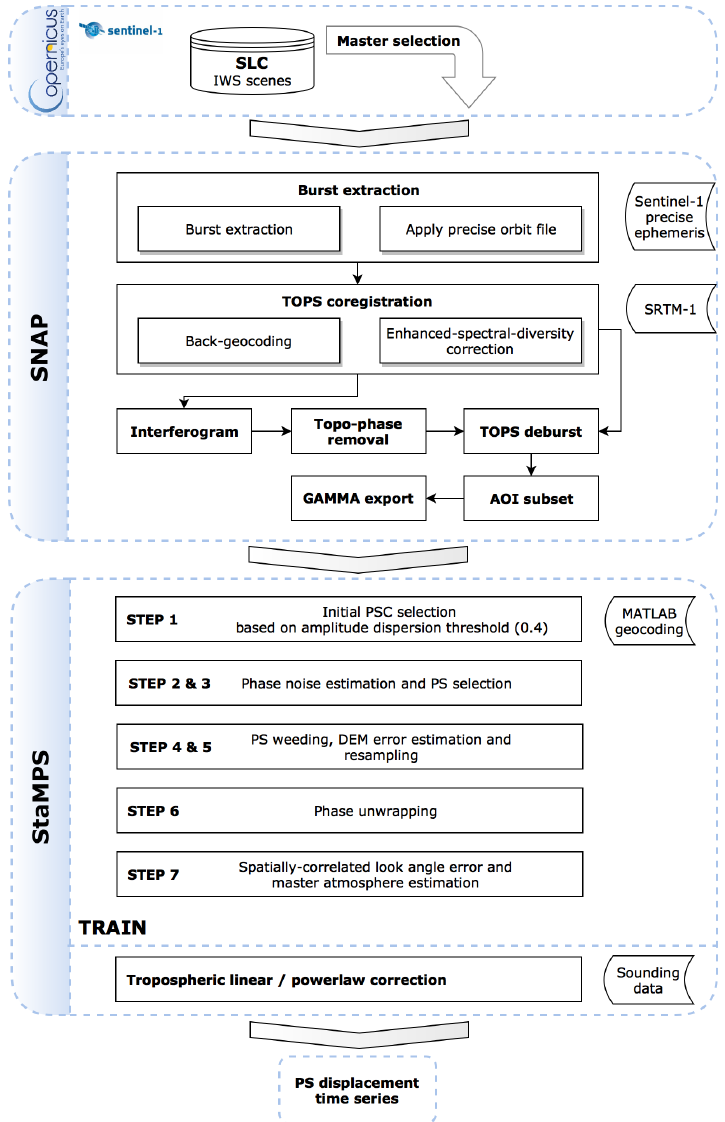
Figure 6. Multi-temporal InSAR analysis incorporated by the SNAP & StaMPS processing